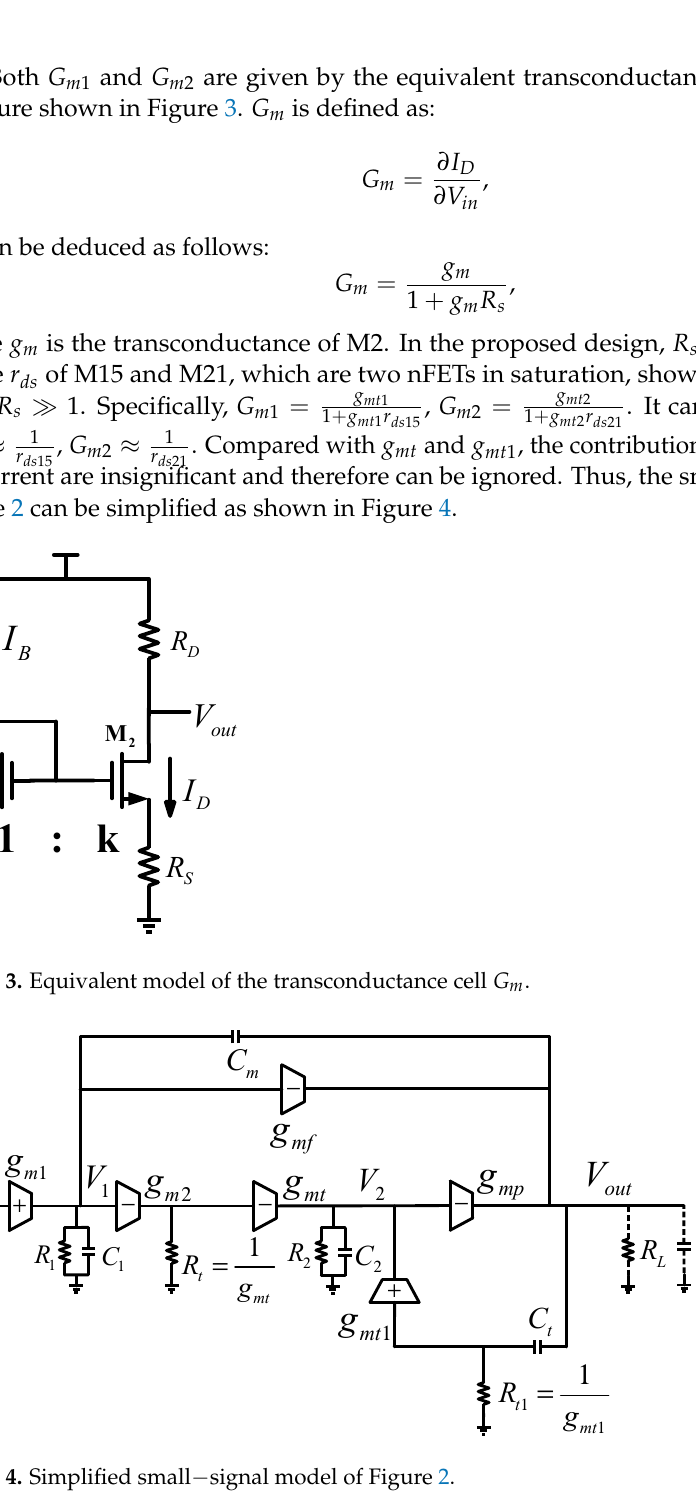
Figure 2. Small − signal model of the proposed OCL − LDO regulator.